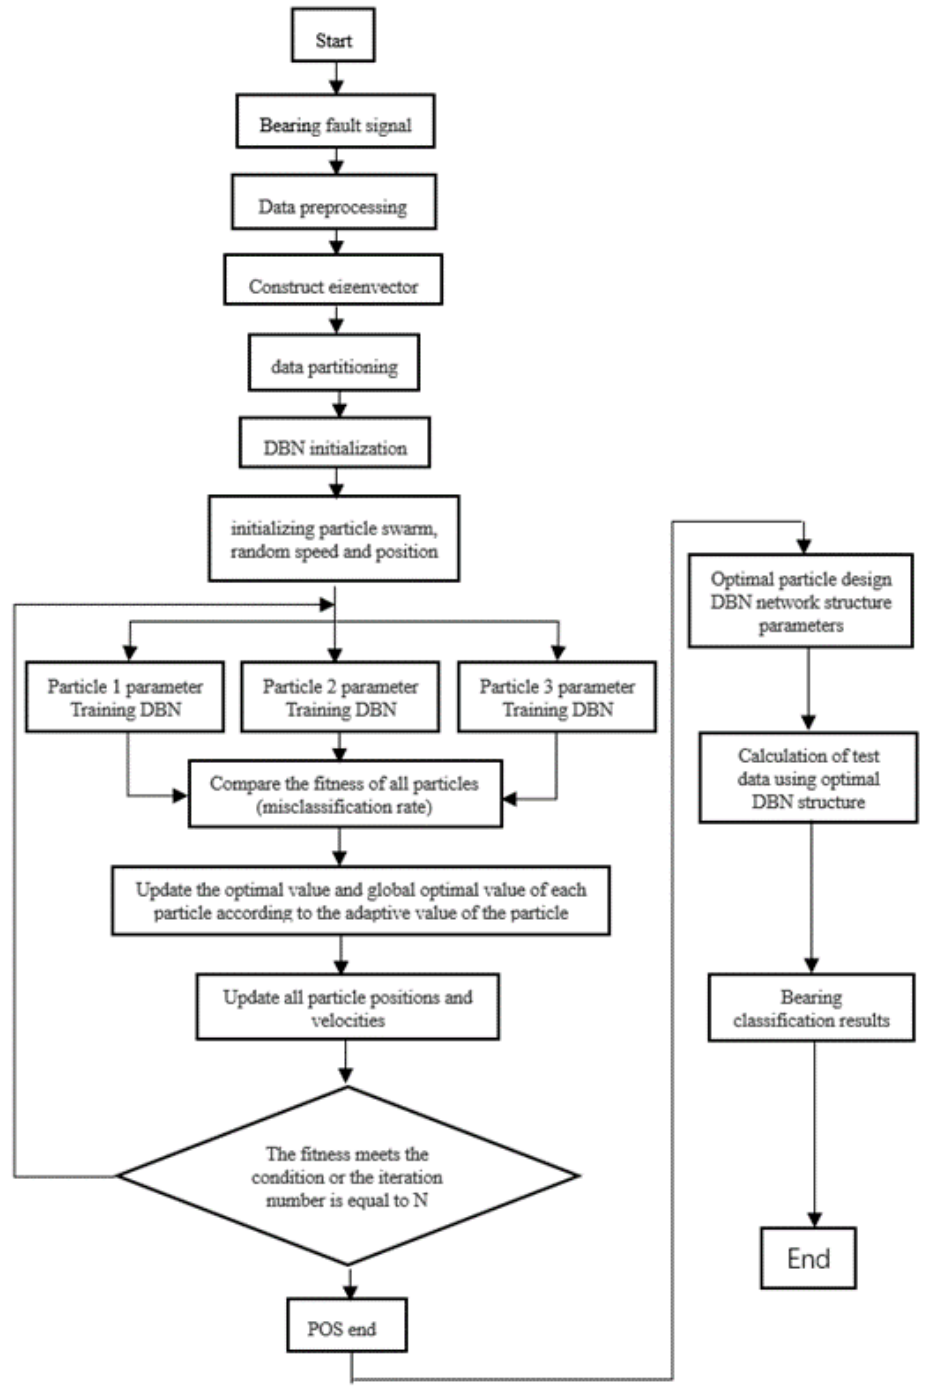
Figure 8. General flow chart of PSO-optimized DBN model.